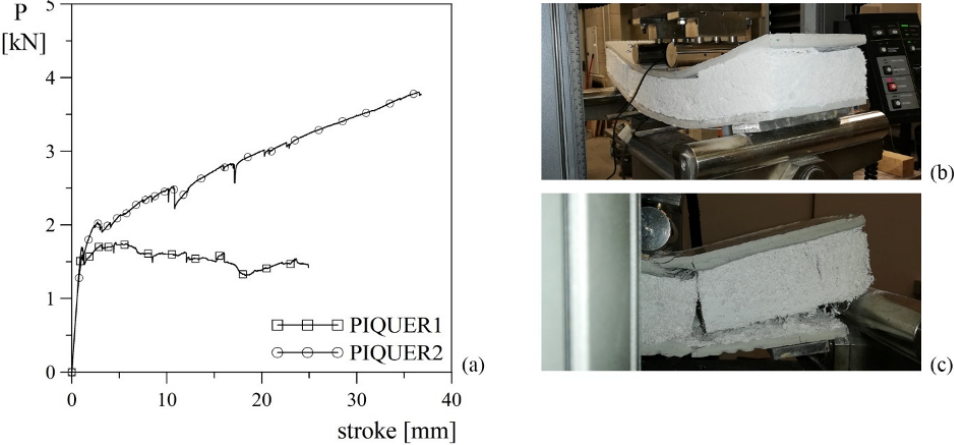
Figure 3. Experimental results (Smart P.I.QU.E.R.): load vs. stroke curves (a) and pictures of specimen PIQUER 2 during the test (b) and at failure (c).